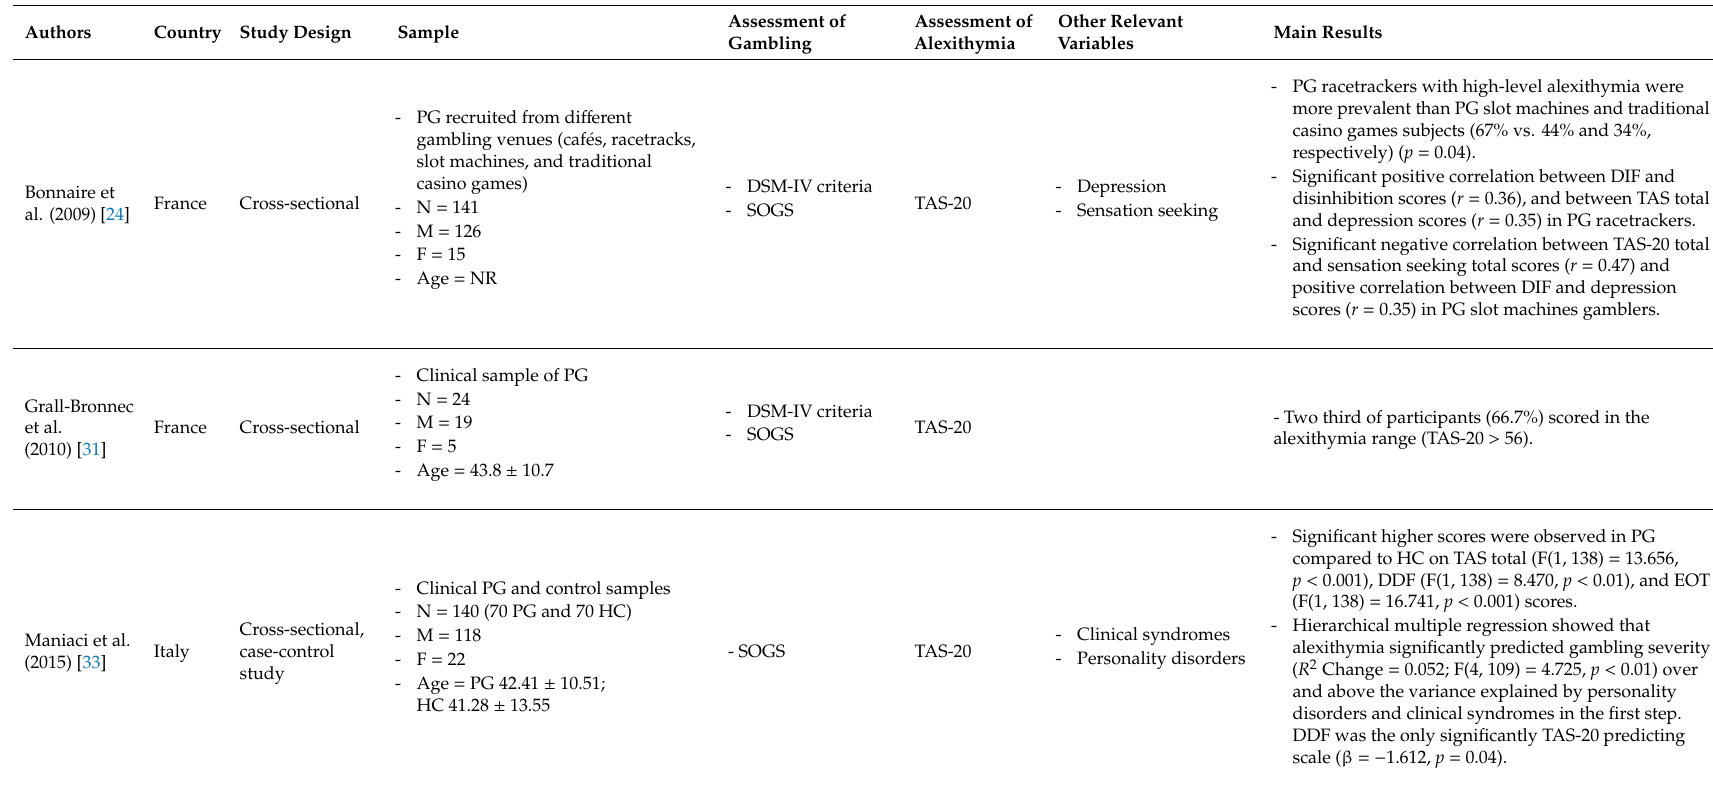
Table 2. Studies on alexithymia and gambling in clinical